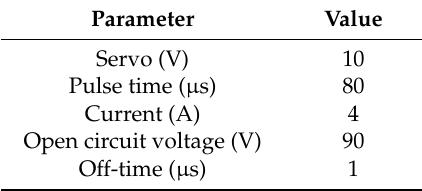
Table 1. Electrical parameters for the second trim cut (taken from ONA AV35 WEDM machine).